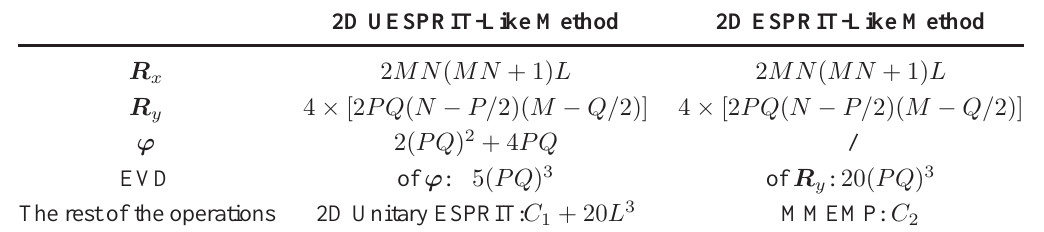
Table 2. Real multiplications required for the 2-D UESPRIT-like and 2-D ESPRIT-like